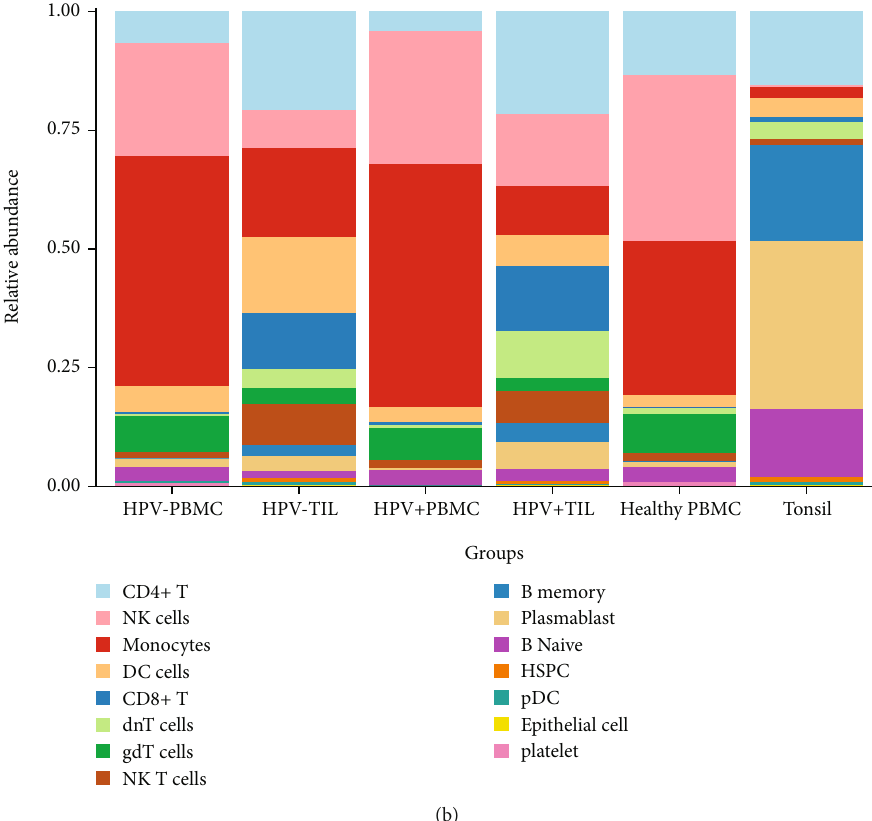
Figure 2: Analysis of the cell population and distribution di ff erences in di ff erent types of tissue. (a) Heatmap plot showing selection of cell type – speci fi c markers across major clusters. The color of the sample represents the relative gene expression level. (b) Bar plot of cell composition in di ff erent groups across cell types and sample